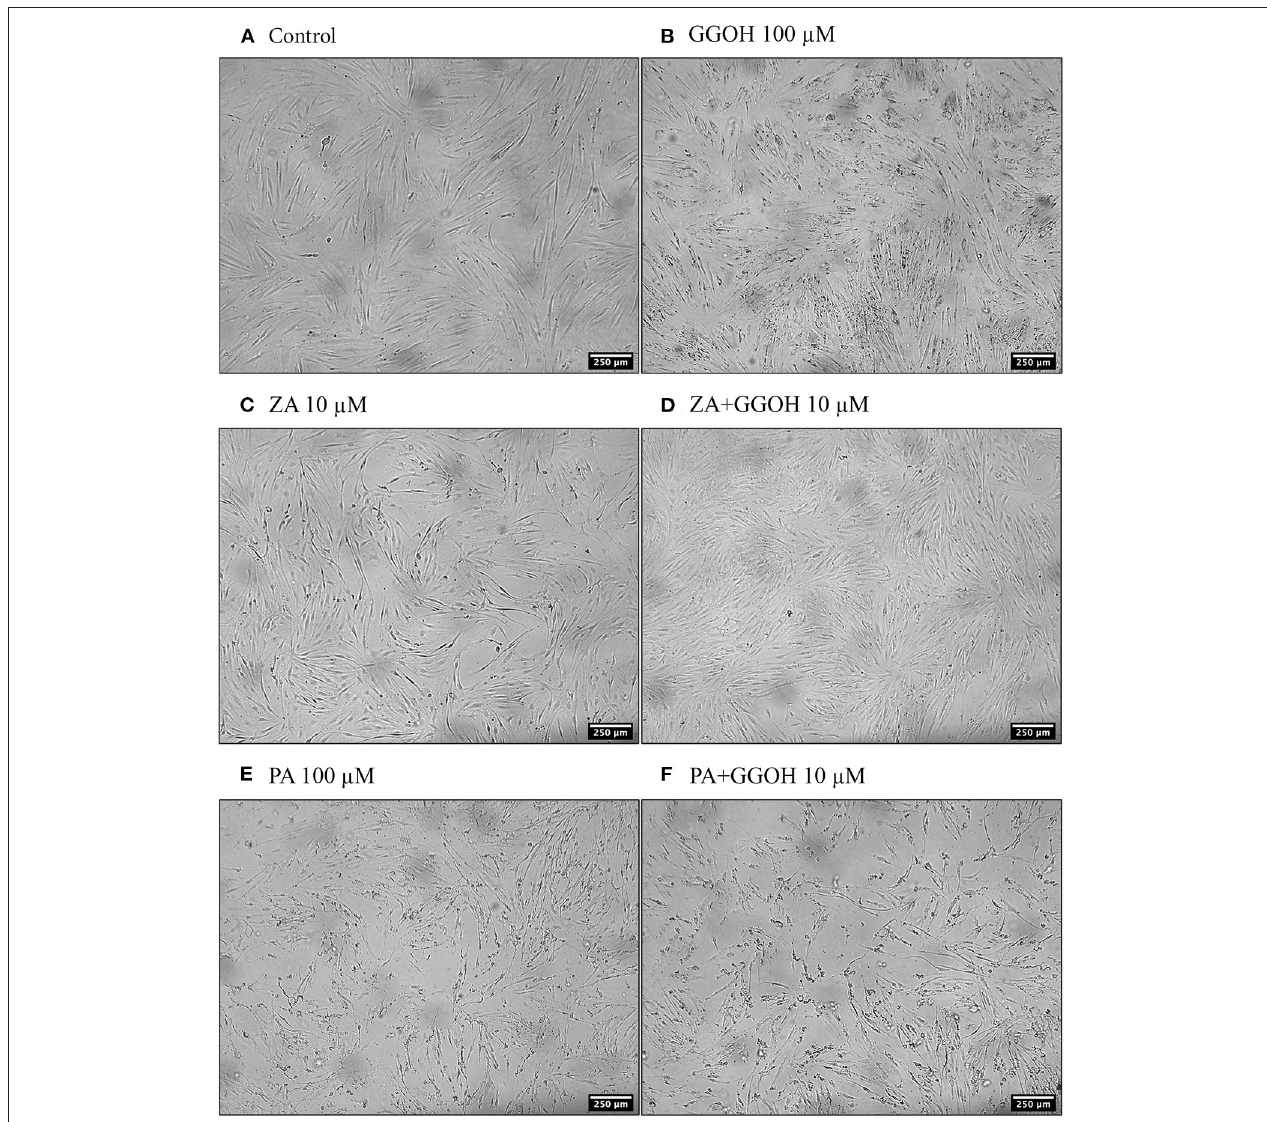
FIGURE 3 | The morphology of oral fibroblasts after 72h of treatment (A) Control (B) GGOH 100 µ M (C) ZA 10 µ M (D) ZA+GGOH 10 µ M (E) PA 100 µ M (F) PA+GGOH 10 µ M. Magnification of 4 × from a light inverted microscope.